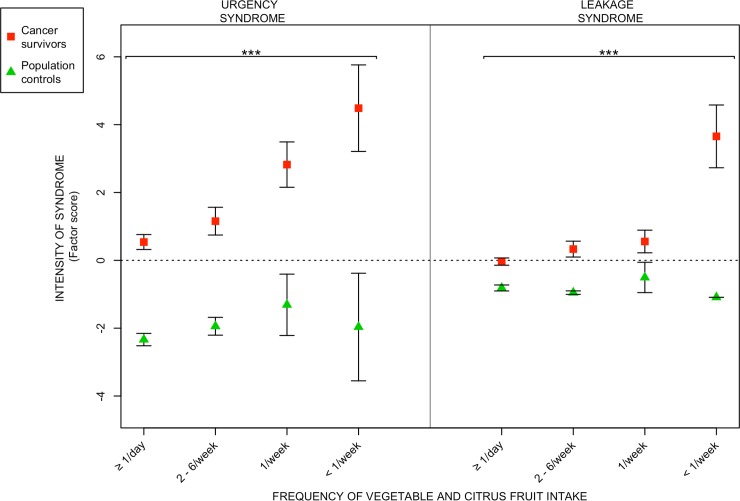
Relationship between radiation-induced survivorship syndromes and frequency of vegetable and citrus fruit intake.The figure depicts the relationships between frequency of combined intake of beans and lentils, cabbage and broccoli, onion and garlic, grated vegetables together with citrus fruits (x-axis) and intensities (factor scores) of the two radiation-induced survivorship syndromes (y-axis) defecation-urgency syndrome and fecal-leakage syndrome among long-term gynecological cancer survivors and population controls. Red squares and green triangles denote the mean syndrome intensities within certain vegetable and citrus intake frequency levels. Vertical black lines stretch between plus-minus the standard error of the mean. Asterisks correspond to significance levels of the Spearman correlations between syndrome intensities and frequency of vegetable and citrus intake according to: p ≤ 0.001 - ***, 0.001 < p ≤ 0.01 - **. 0.01 < p ≤ 0.05 - *. Estimates of the Spearman correlations are found in Tables 2 and 3.